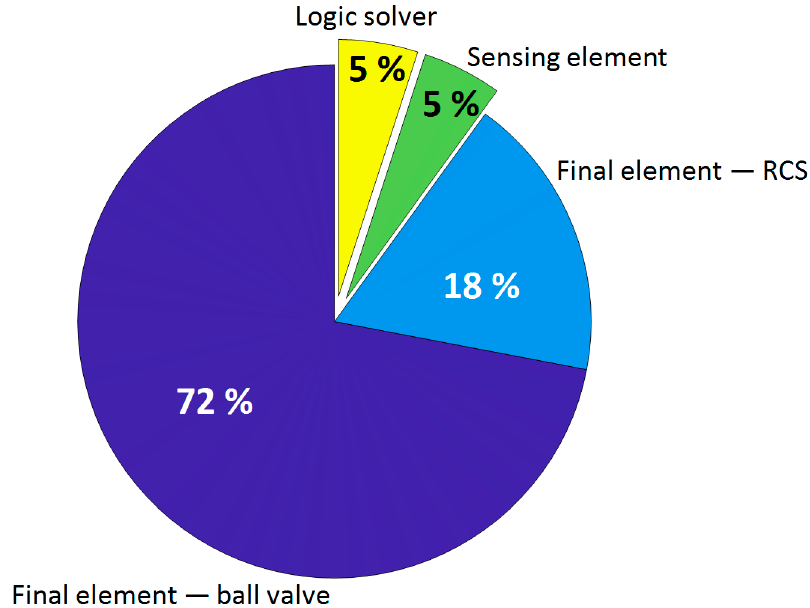
Figure 7. Pie chart of each contribution of the probability of failure on demand. The percentages were obtained by normalizing results achieved in Equations (4)–(8).